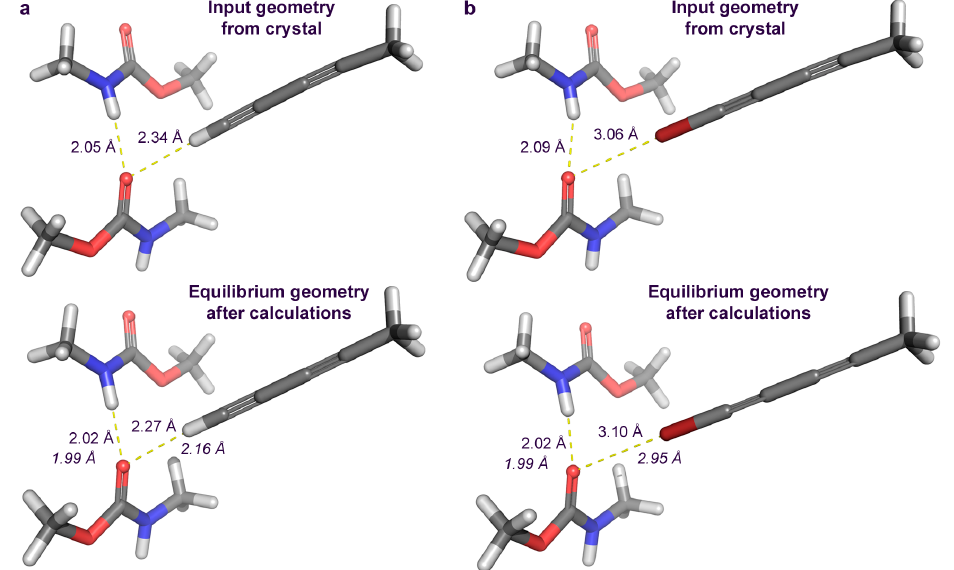
Figure 6. Starting (crystal) and equilibrium (DFT minimization) geometries for ( a ) system 8 - 8 - 9 and for ( b ) system 8 - 8 - 10 . Plain figures in the equilibrium geometries are for B3LYP calculations and italic figures for M06-2X calculations. Table 2. DFT energies for the minimized geometries.